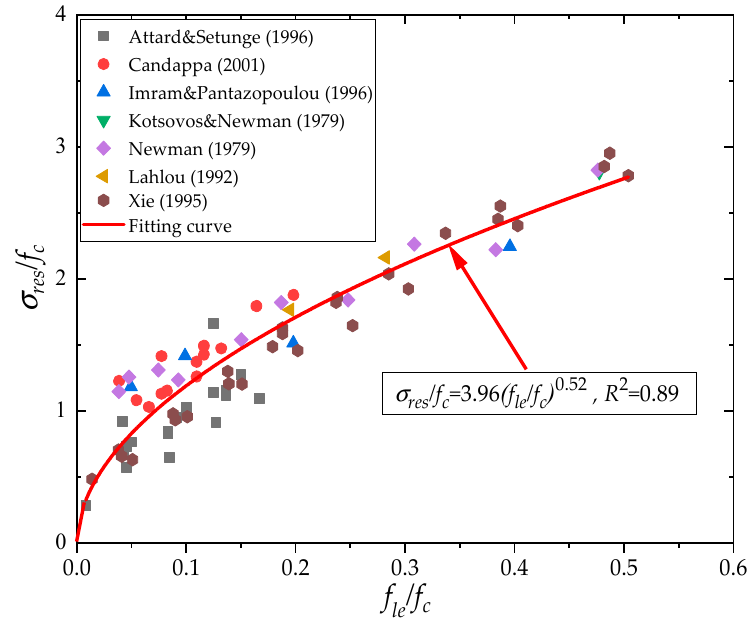
Figure 14. Relationship between σ res / f